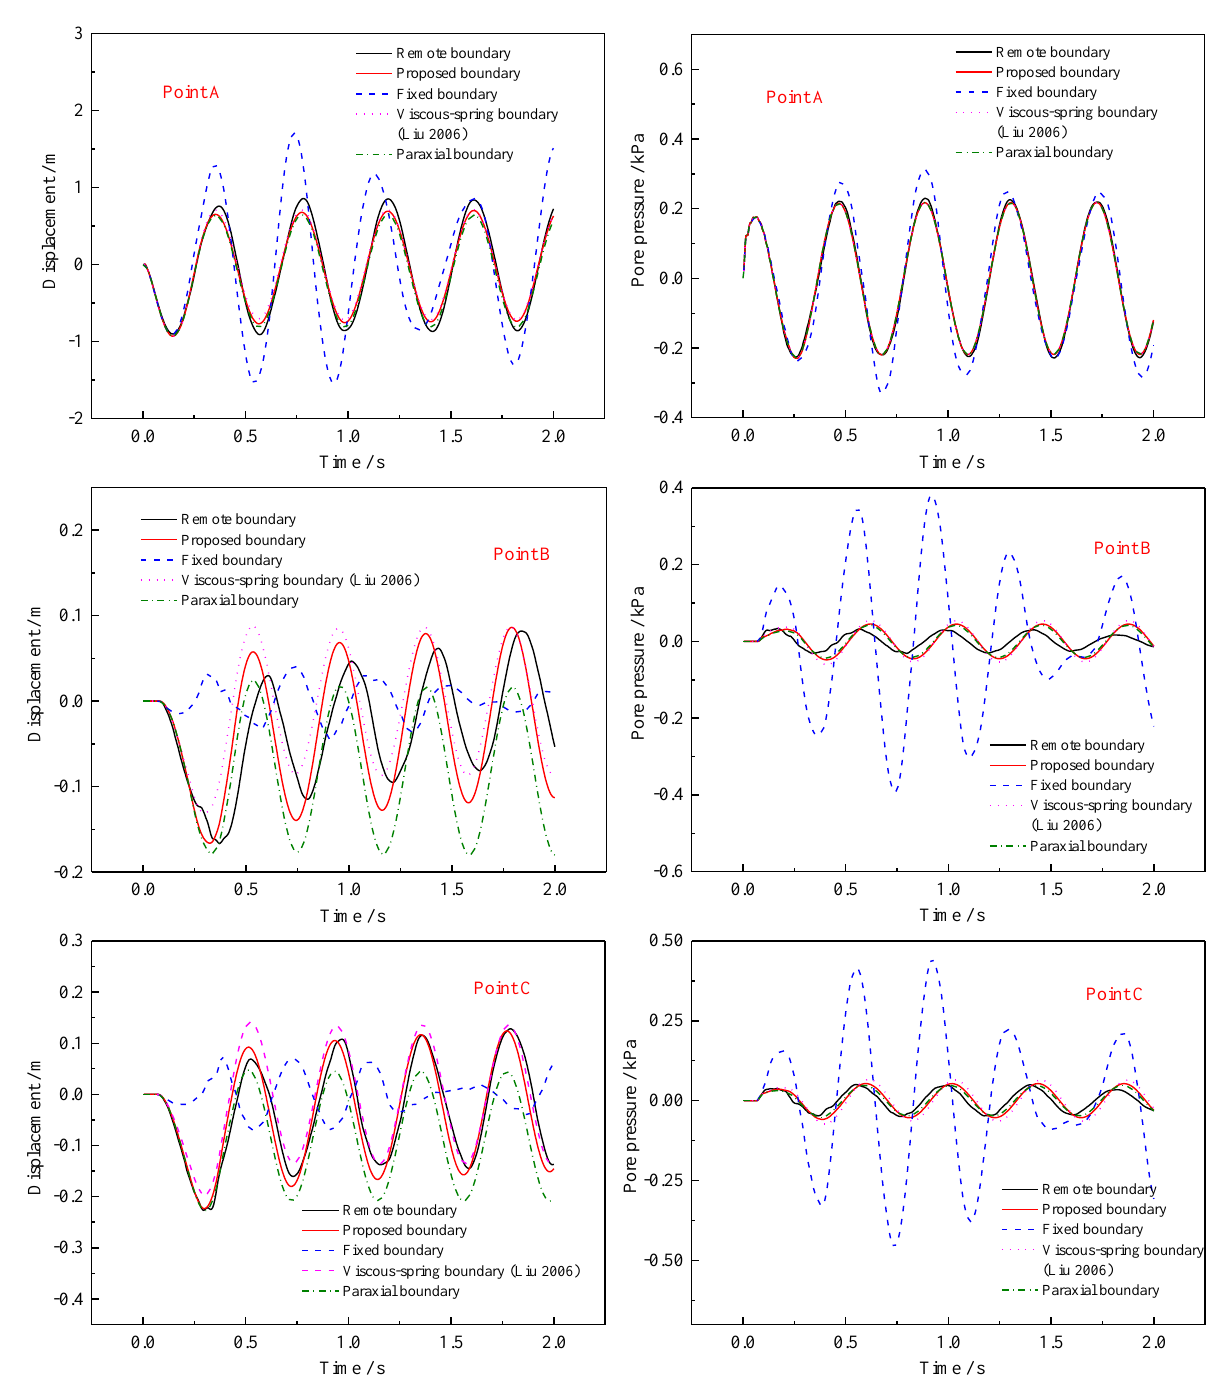
Figure 5. Vertical displacement and pore pressure time histories of the two-dimensional model with different boundaries [51].